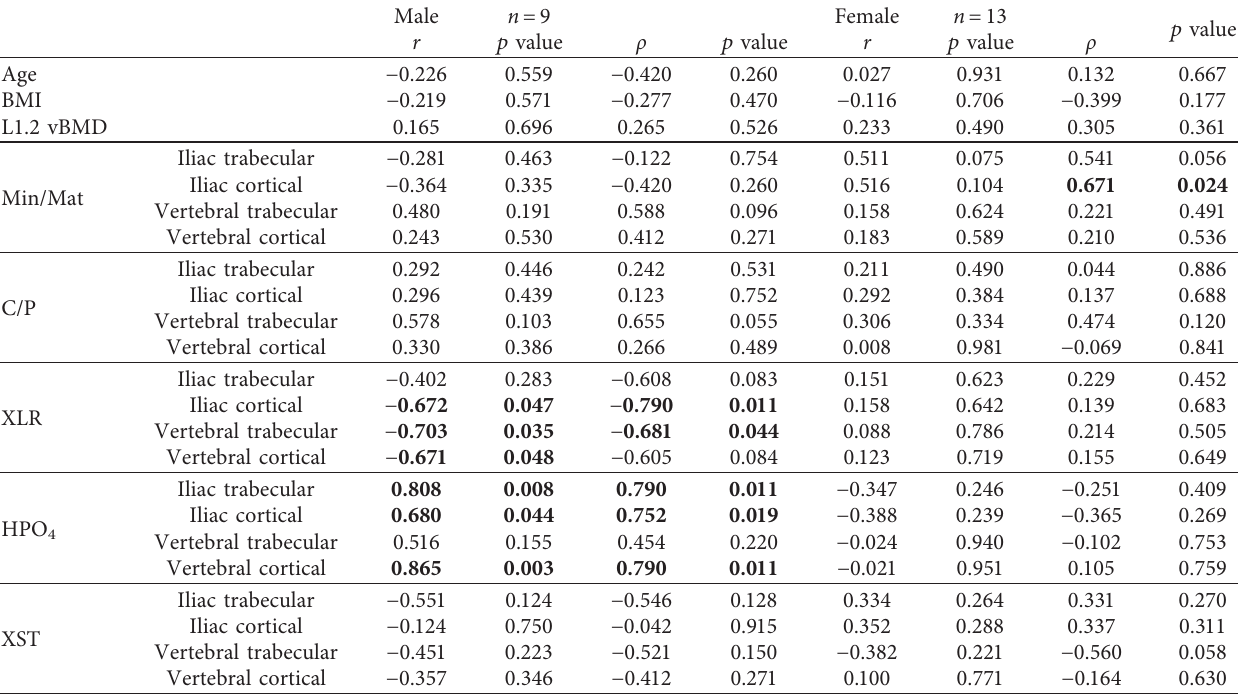
Table 4: Correlations between uNTX and FTIR parameters: univariate analyses.